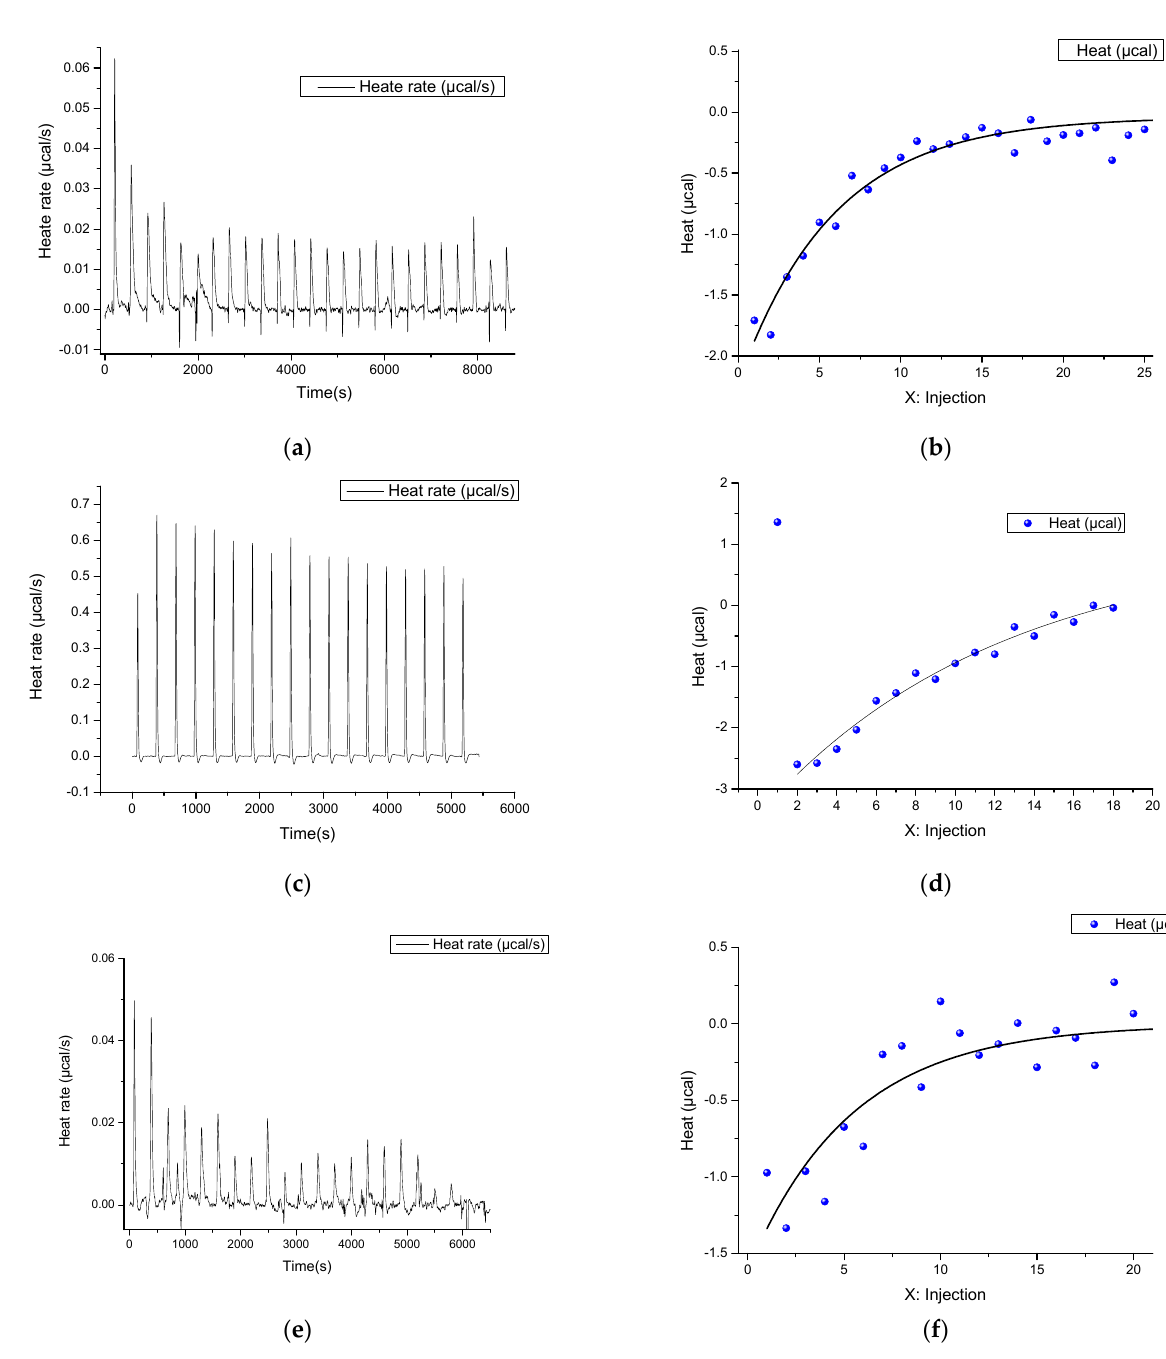
Figure 3. The ITC profiles ( a , c , e ) and corresponding integrated areas of each heat burst curve plotted as a function of injection number ( b , d , f ) for interaction of RNA with ssDNA ( a , b ), Cas9 with RNA ( c , d ) and Cas9–RNA complex with dsDNA ( e , f ).